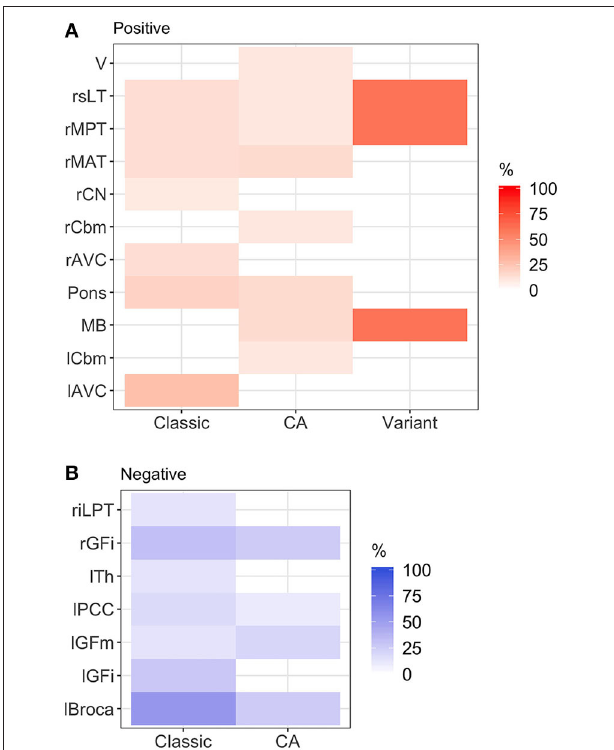
FIGURE 1 | Heatmap of abnormal brain regions by phenotype. (A) Hypermetabolic brain regions: brainstem hypermetabolism was seen in all phenotypes. Cerebellar hypermetabolism (left cerebellum, right cerebellum, and vermis) was seen in pure cerebellar ataxia. (B) Hypometabolic brain regions: hypometabolism was seen more commonly in classic stiff person syndrome (SPS) phenotype. Classic, classic SPS; CA, pure cerebellar ataxia; Variant, SPS-plus. Abnormal brain region was defined by Z-score > 1.65 or < -1.65. rGFi, right inferior frontal cortex; lPCC, left posterior cingulate cortex; lGFi, left inferior frontal cortex; lGFm, left mid frontal cortex; lTh, left thalamus; rMAT, right anterior medial temporal cortex; rCN, right caudate nucleus; MB, midbrain; rMPT, right posterior medial temporal cortex; rsLT, right superior lateral temporal cortex; lAVC, left associative visual cortex; riLPT, right inferior lateral posterior temporal cortex; rCbm, right cerebellum; rMAT, right anterior medial temporal cortex; V, vermis; rMPT, right posterior medial temporal cortex; lCbm, left cerebellum; rsLT, right superior lateral temporal